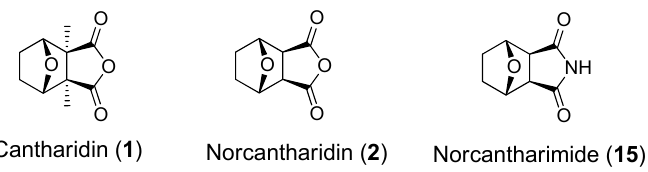
Figure 1. Chemical structures of cantharidin ( 1 ), norcantharidin ( 2 ) and norcantharimide ( 15